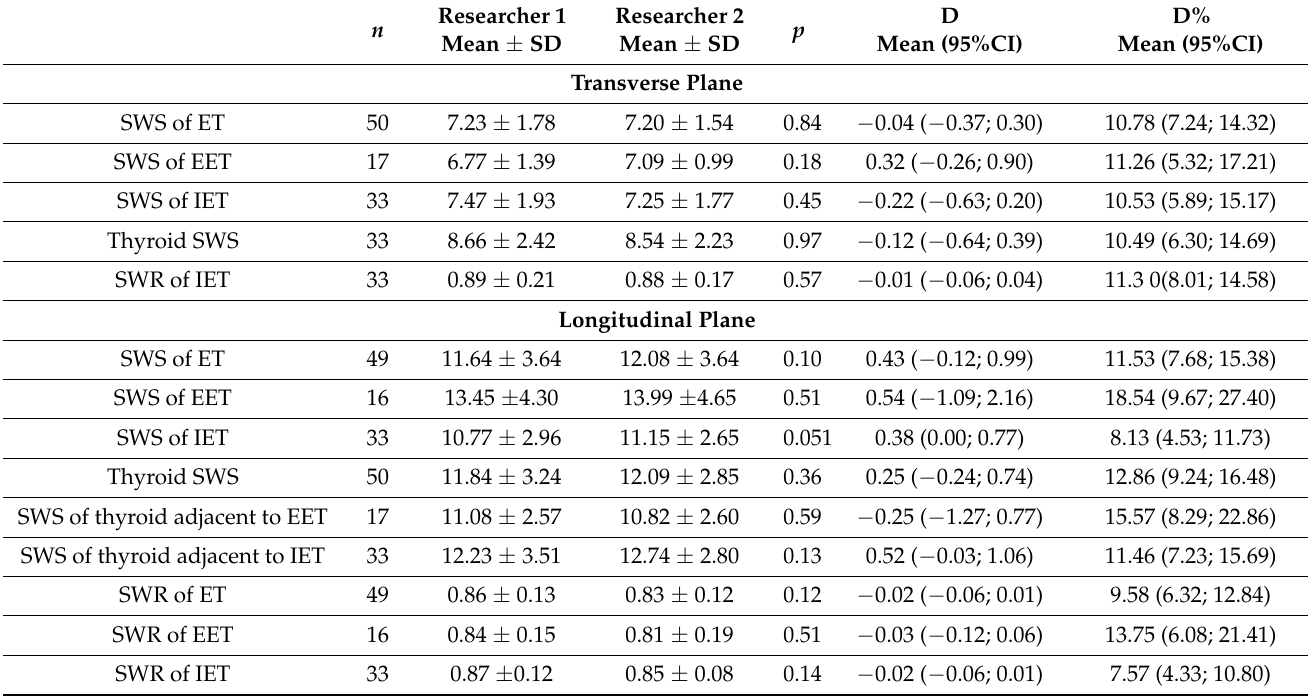
Table 1. Comparison between SWS and SWR values obtained by two independent researchers.